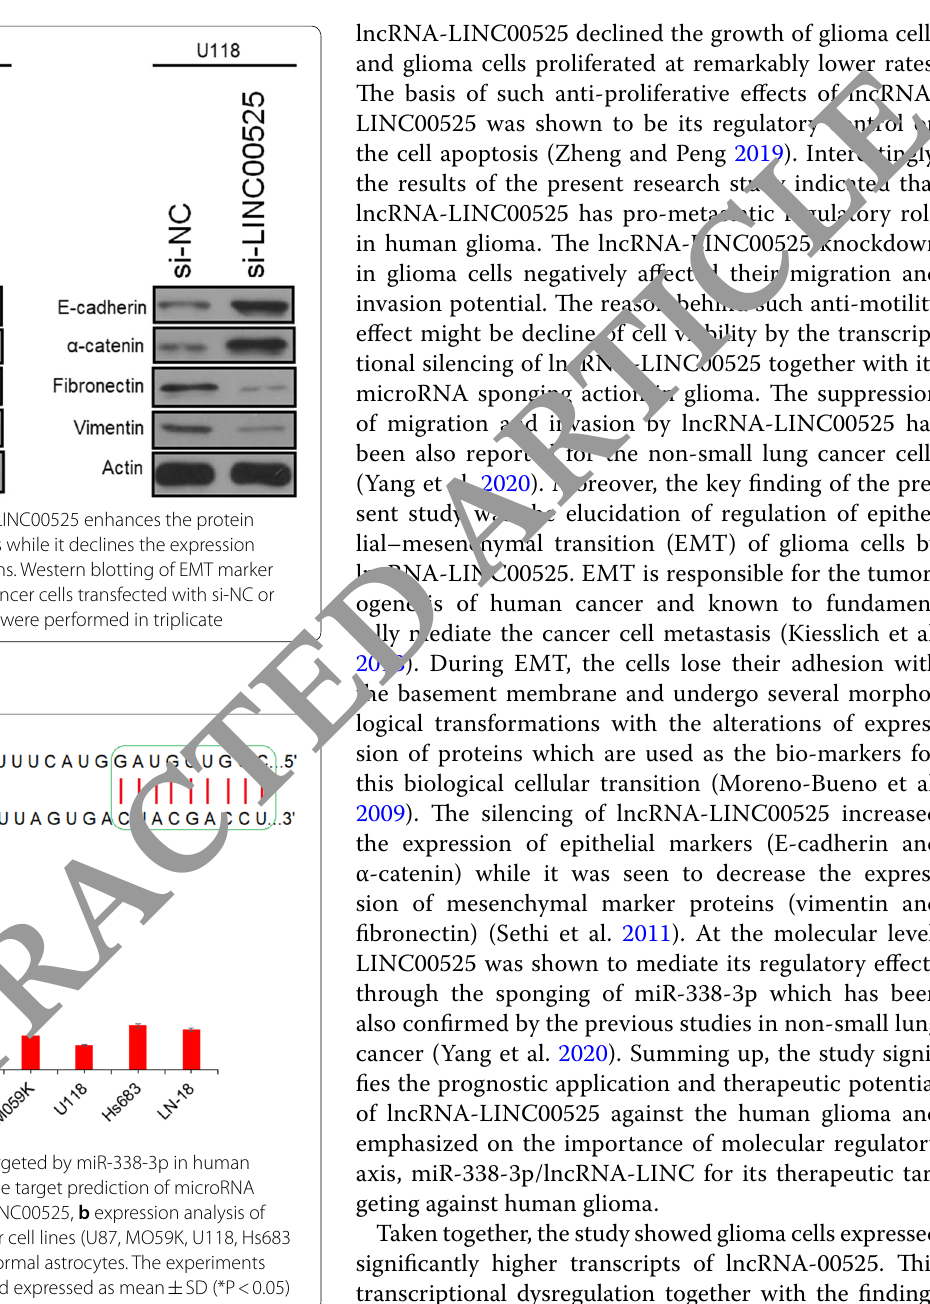
Fig. 6 lncRNA-LINC00625 is targeted by miR-338-3p in human glioma. a In silico analysis for the target prediction of microRNA specifically targeting lncRNA-LINC00525, b expression analysis of miR-338-3p from glioma cancer cell lines (U87, MO59K, U118, Hs683 and LN-18) in comparison to normal astrocytes. The experiments were performed in triplicate and expressed as mean